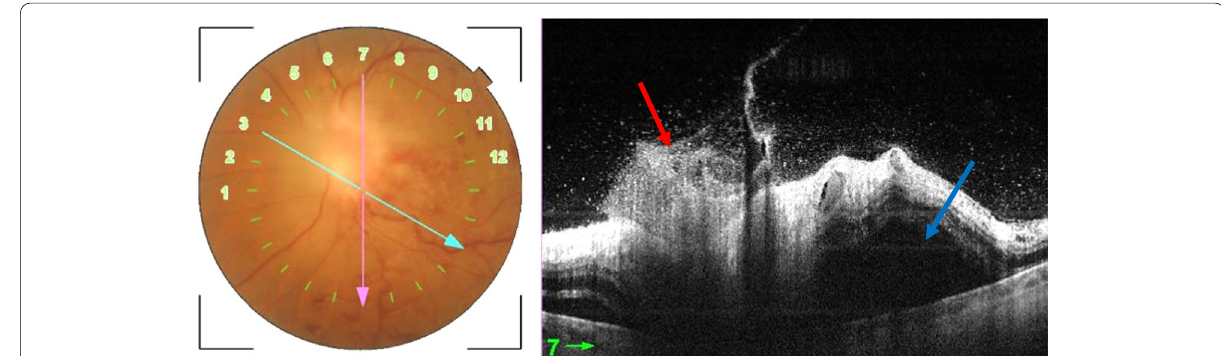
Fig. 3 Initial SS OCT scan through the left optic disc exhibiting a hyperreflective lesion in the pre-papillary vitreous area corresponding to the pre-papillary vitreous infiltrate (red arrow) as well as an important optic disc swelling with a large serous retinal detachment extending to the macula (blue arrow)